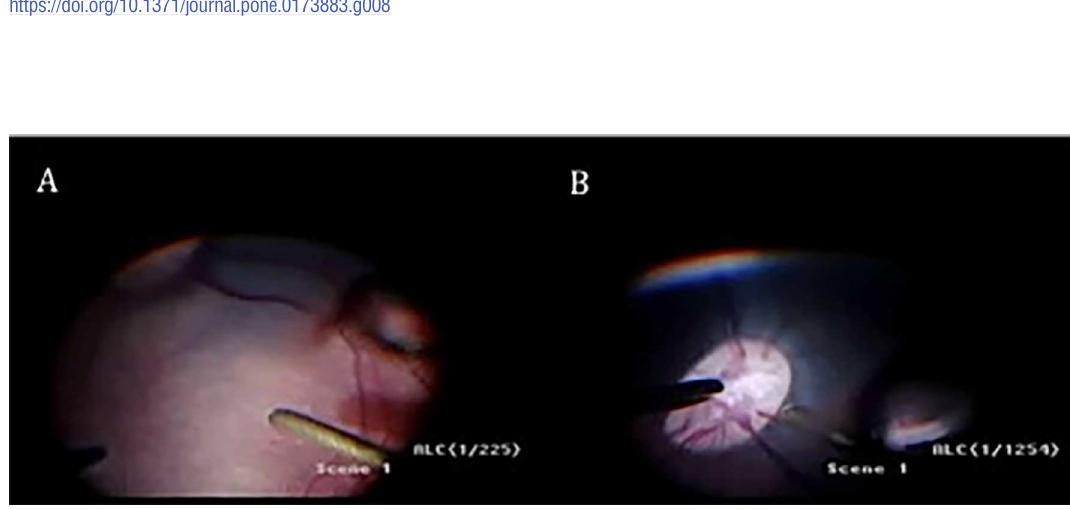
Fig 8. Transmission electron microscopy of human vitreous samples after pars plana vitrectomy with the guillotine vitrector. (A, B, C) GV at 3000 cuts per minute. (D, E, F) GV at 5000 cuts per minute. The figures show less fragmentation of the collagenfibrils comparedto those obtained from the hypersonic vitrector shown in Fig 7.